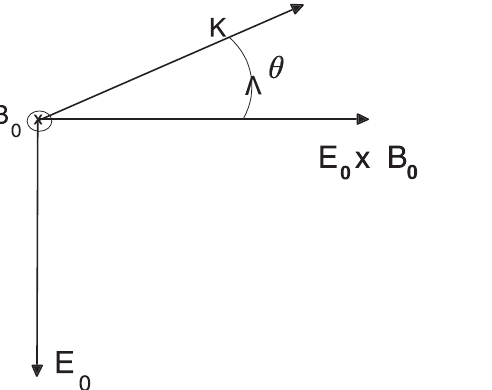
Fig. 1. Coordinate system being used to describe the angle h in the Pedersen